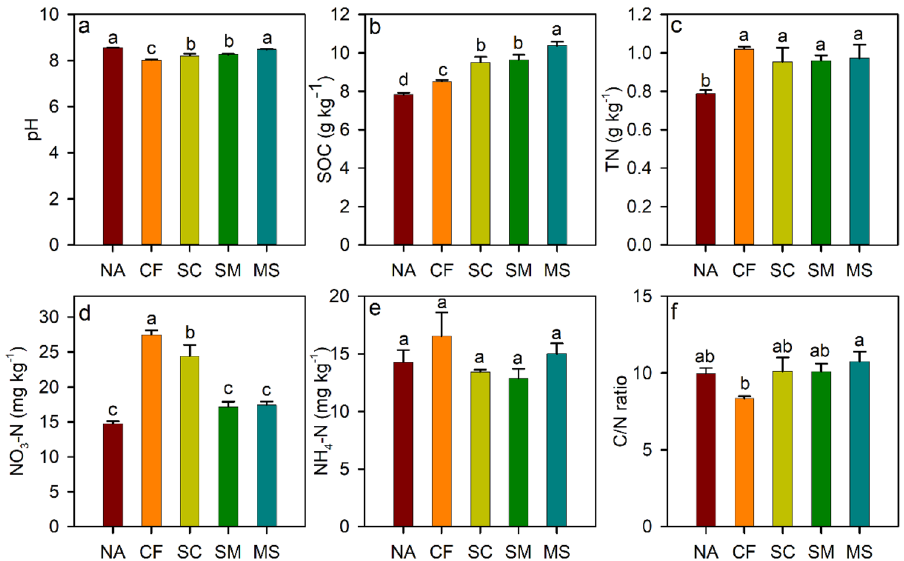
Figure 1. Soil properties under different treatments. SOC, soil organic carbon; TN, total nitrogen; NO 3 -N, nitrate nitrogen; NH 4 -N, ammonium nitrogen; C/N ratio, SOC to TN ratio. NA, no fertilizer; CF, inorganic fertilizer; SC, inorganic fertilizer plus organic fertilizer; SM, organic fertilizer; MS, maize straw. Different letters indicate significant difference at p <